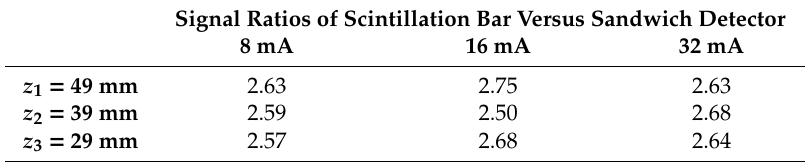
Table 2. Calculated signal ratios for directly exposed bar versus sandwich detector for various electron beam currents and detector exposure heights z